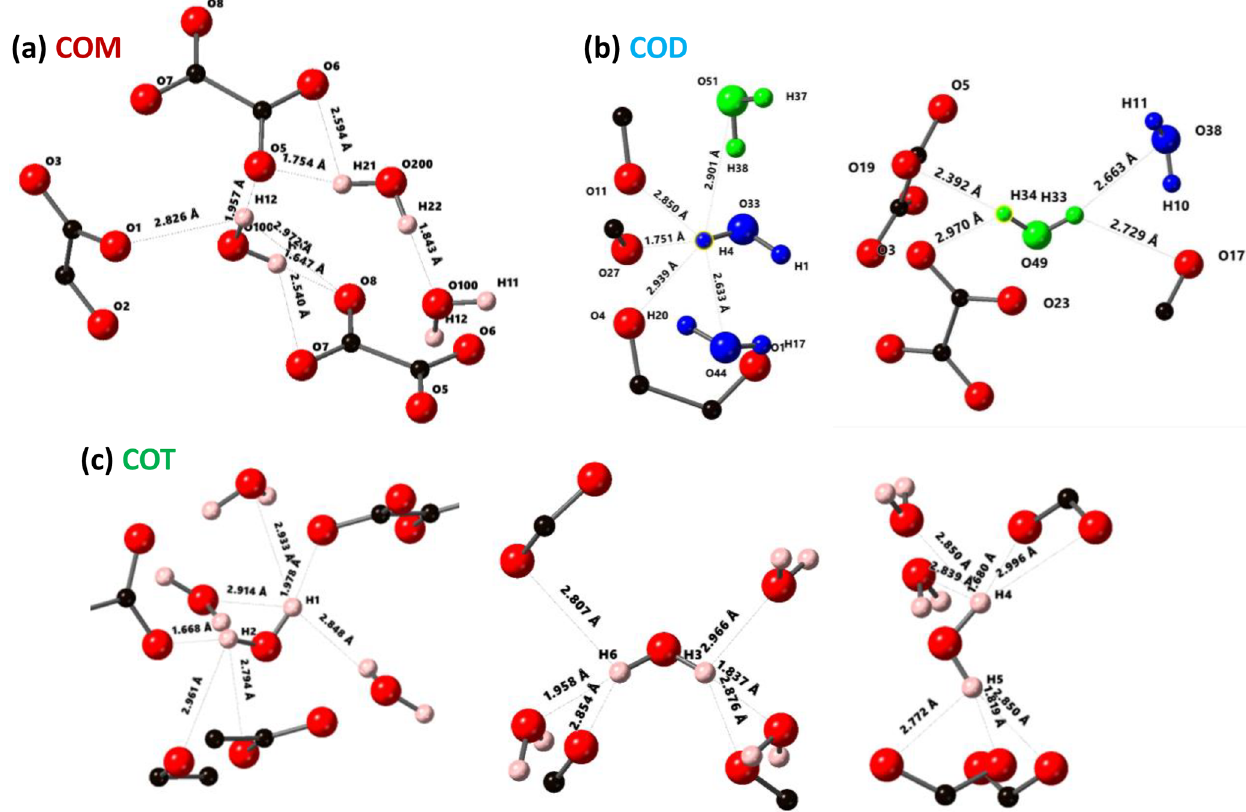
Figure 3. Structural details of COM (a) , COD (b) and COT (c) . For each proton of the water molecules, the shortest O − H ... O distance (in Å) is represented, together with the number of H ... O contacts (3Å cut-off). For COT, the number of H ... O contacts is high (three to four), and the COT structure is considered as being rigid. In the case of COD, the structural and zeolitic water molecules are represented in blue and green, respectively. A selection of rigid (H4) and less rigid (H33 or H34) water molecules is presented. All distances and the number of H ... O contacts are summarized in Table A1. Color code: red is O, black is C and light pink is